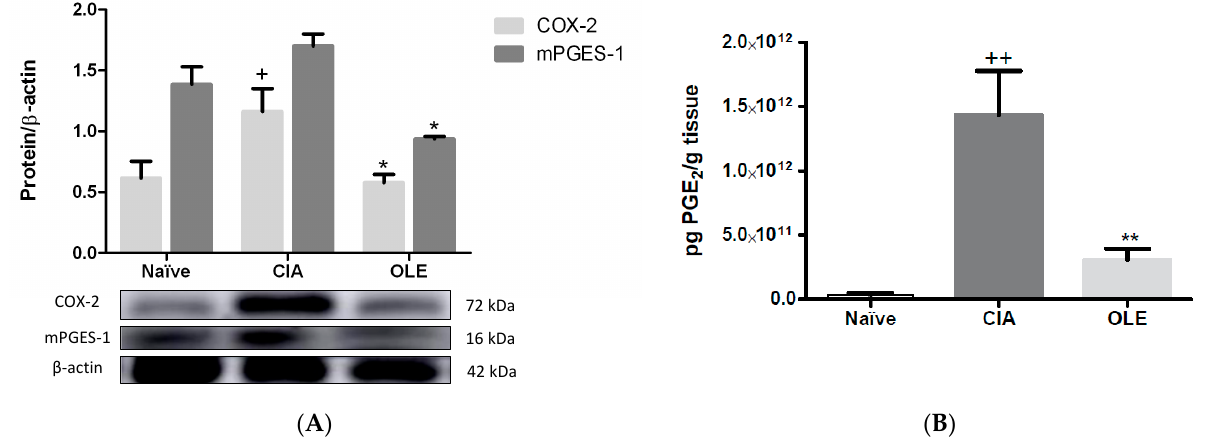
Figure 4. Modulation of COX ‐ 2/mPGES ‐ 1 axis and PGE 2 synthesis in dietary OLE supplemented group in hind paws. ( A ) COX ‐ 2 and mPGES ‐ 1 protein expression were analyzed by Western blotting and quantified by densitometrical analysis. ( B ) Quantification of PGE 2 levels using ELISA kit. Western blot images are representative of separate experiments with similar results. Naïve group, non ‐ arthritic control animals fed with SD; CIA, control group induced arthritic animals fed with SD; OLE induced arthritic animals fed with OLE enriched diet (0.025% w/w ). Values represented mean ± S.E.M. ( n = 8), + p < 0.05; ++ p < 0.01 vs. Naïve control group; * p < 0.05; ** p < 0.01 vs. CIA group.